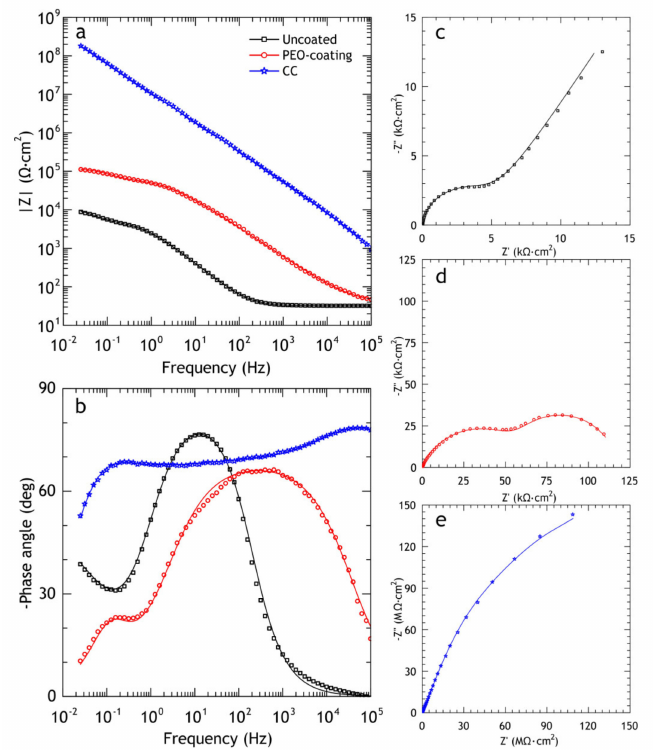
Figure 8. Impedance data obtained in 3% NaCl for the studied samples. Bode—( a , b ) and Nyquist plots for the bare alloy ( c ), PEO ( d ) and composite ( e )